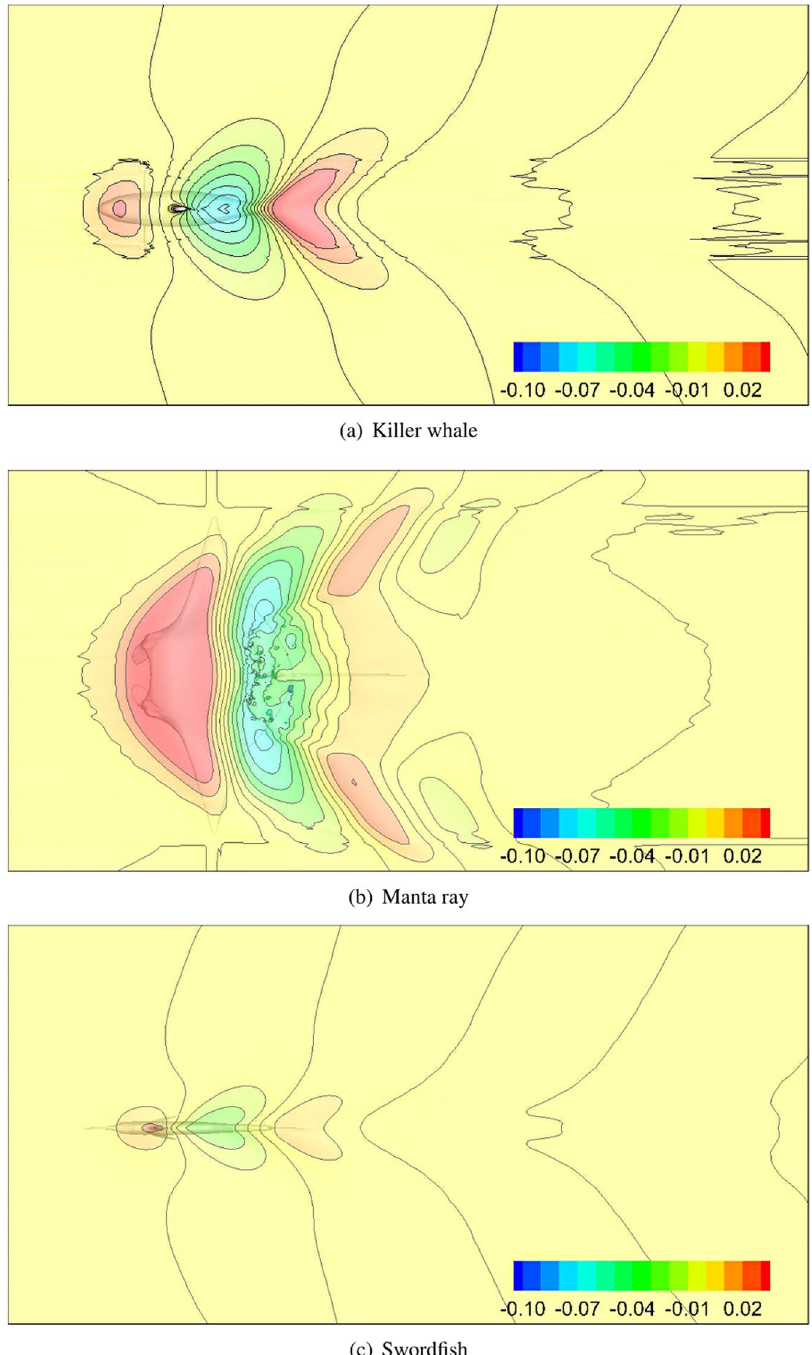
Figure 5. Top view of water-air surface for Case NS. Colored section corresponds to ( Z − Z 0 )/ L , where Z is the z-coordinate, and Z 0 is the initial surface elevation. The CAD models are created in Rhinoceros 17